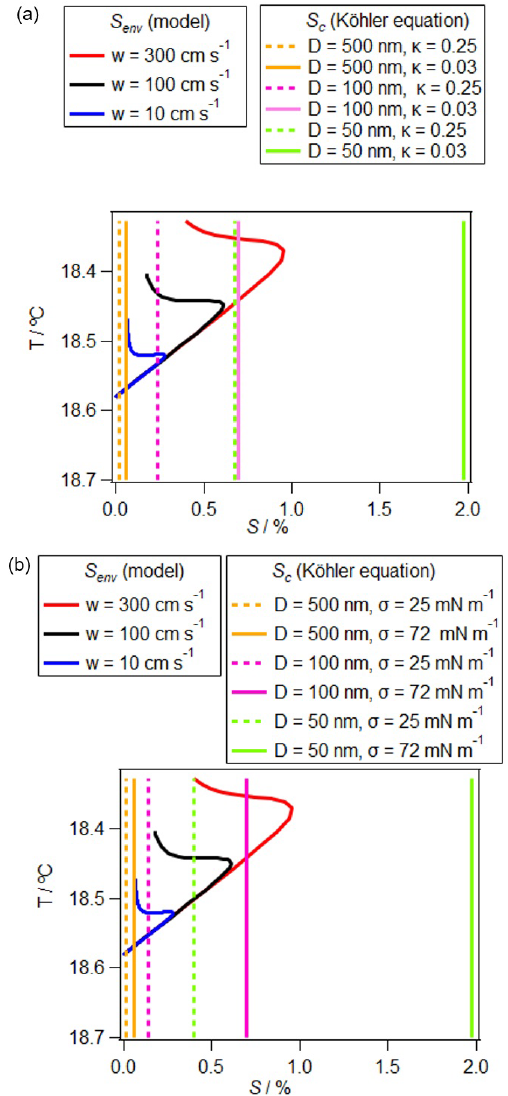
Figure 8. Comparison of the environmental supersaturation within the cloud ( S env ) as predicted by the parcel model for different up- draft velocities ( w ) to the critical supersaturation ( S c ) of PBAPs based on Köhler theory. Results are shown as a function of (a) hy- groscopicity parameters κ PBAP and (b) surface tension σ PBAP . In- put parameters to the parcel model are listed in Table